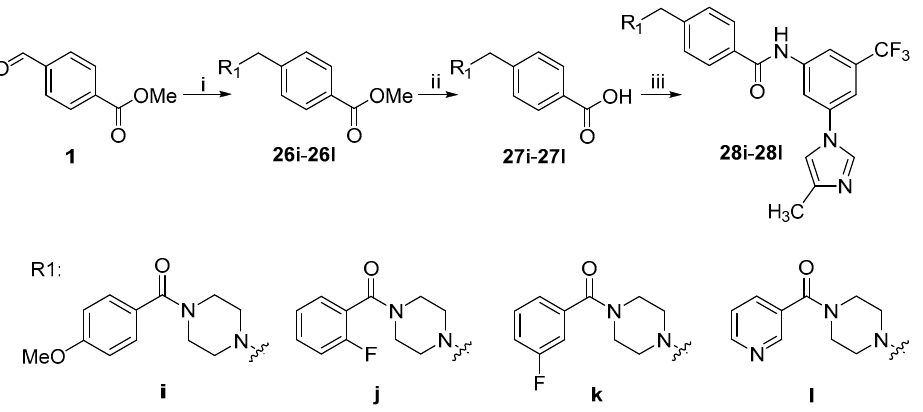
Table 2. In vitro anti-proliferative activities of targets compounds against cancer cells (K-562, HL-60, MCF-7, Hela, A-549, OKP-GS) and human normal cells (RPMI 1788). Anti-proliferative activities in different cancer cell lines (IC 50 (µ М ) Comp. Log P b (TPSA)